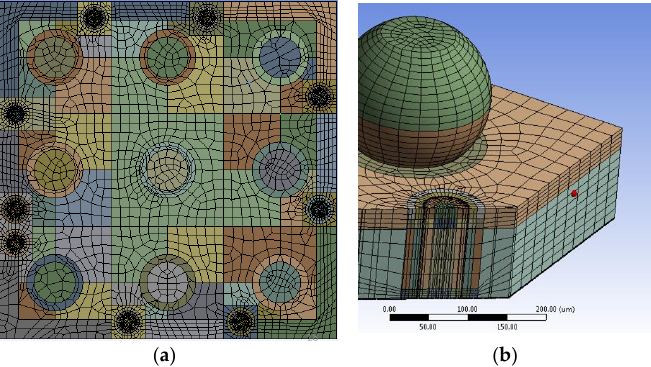
Figure 5. Mesh patterns ( a ) in a top view of MEMS die; ( b ) in a cross-section view of a TSV of Type A (PCB not shown). Various colors indicate different meshing blocks. Table 1. Material Properties for FEA models.